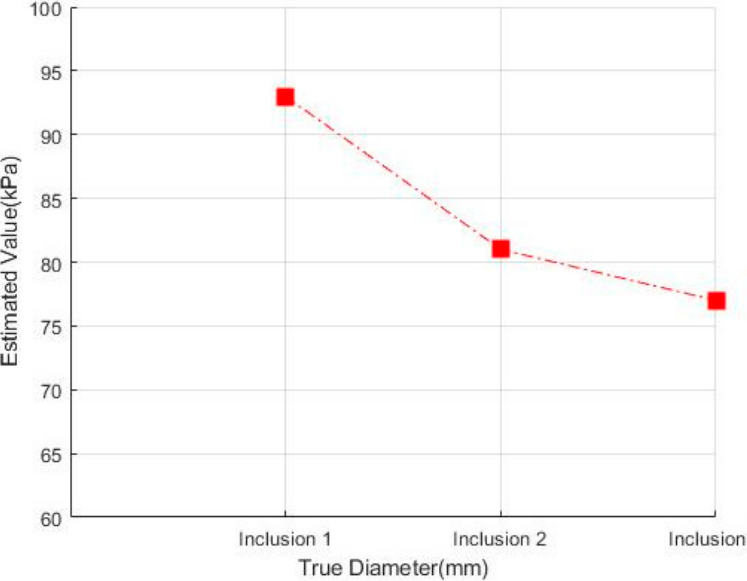
Figure 22. Z-score graph according to the degree of elasticity.